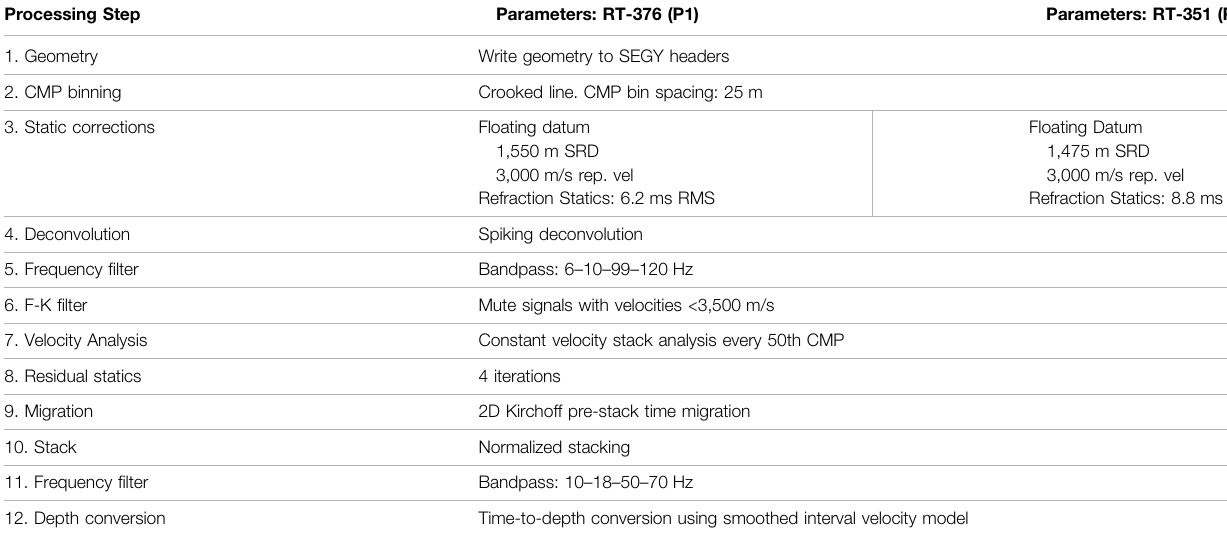
TABLE 2 | Processing fl ow of seismic pro fi